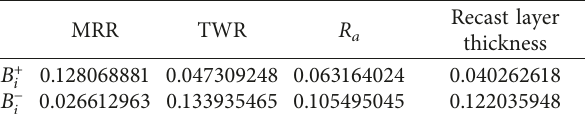
Table 8: Determination of ideal ( B + MRR